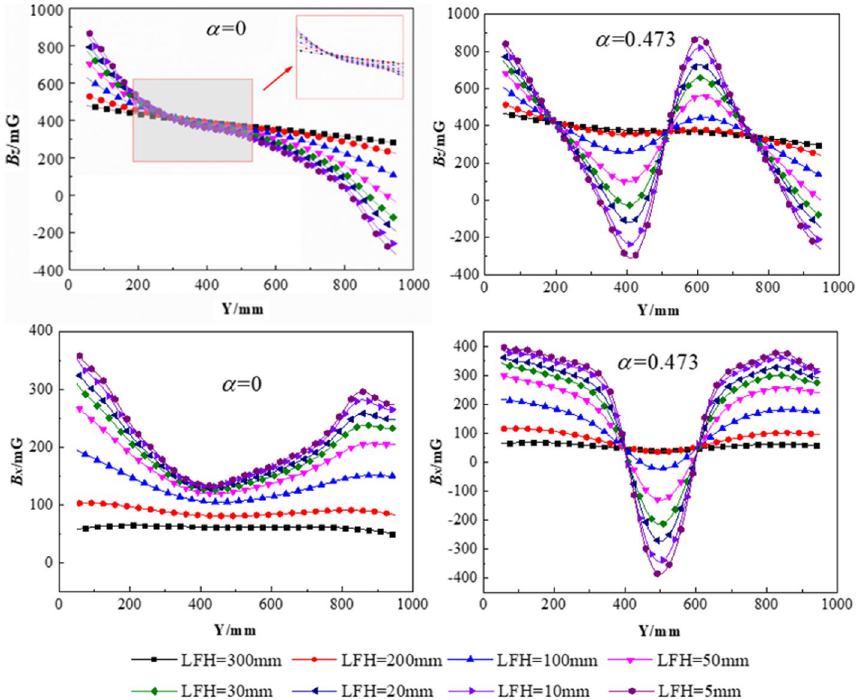
Fig. 9 Bz curve and Bx curve of specimen 26# before and after